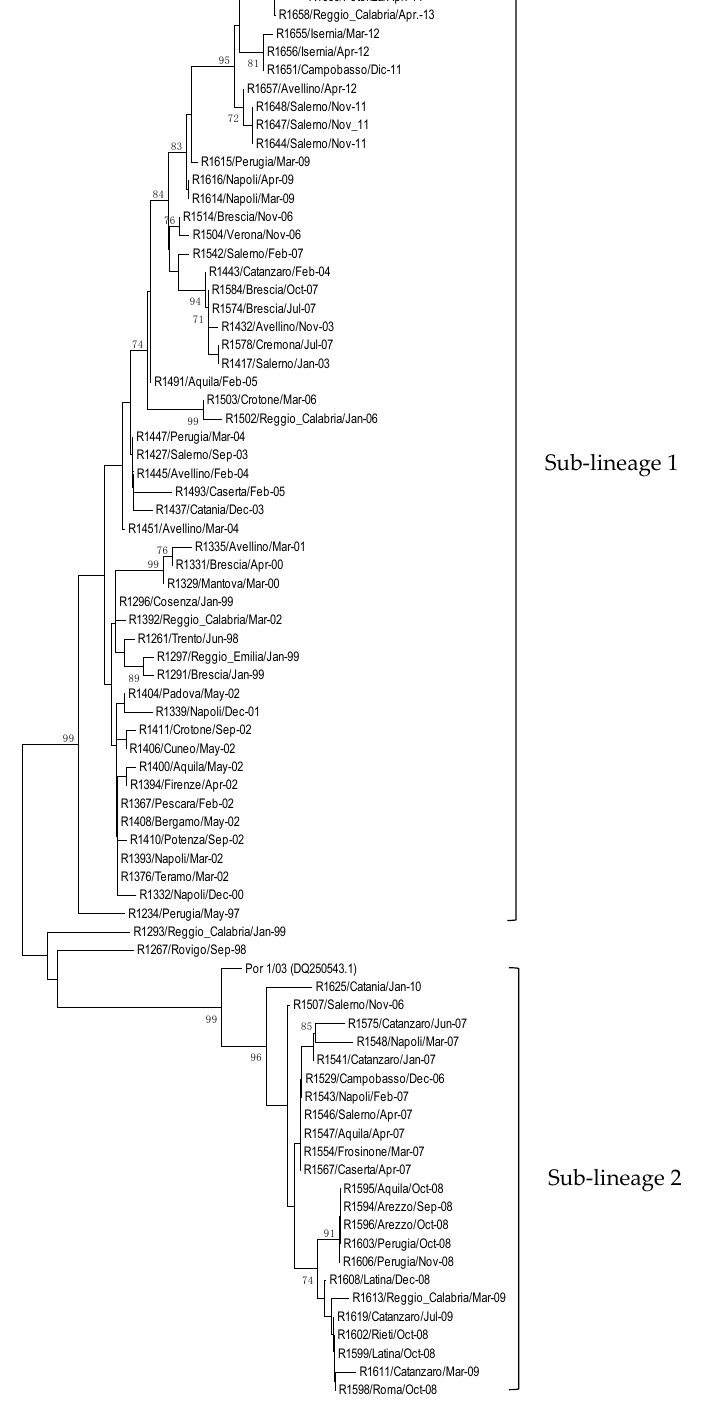
Figure 1. Phylogenetic tree derived from a nucleotide sequence fragment (433 nt) of 3D gene from the 78 Italian SVDV-positive samples (the Portuguese strain Por 1/03 retrieved from GenBank is also included). The two viral clusters named sub-lineage 1 and 2 correspond to those identified by the phylogenesis based on VP1 sequences. The designation of tree reconstruction is performed as described in the materials and methods using the program MEGA neighbor-joining method and bootstrapped with 1000 replicates. Only bootstrap values higher than 70% are shown.